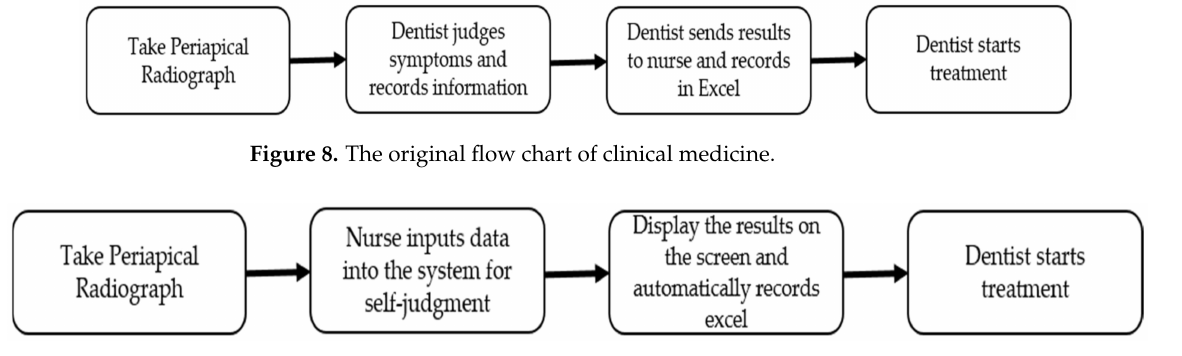
Figure 9. The flow chart of using this